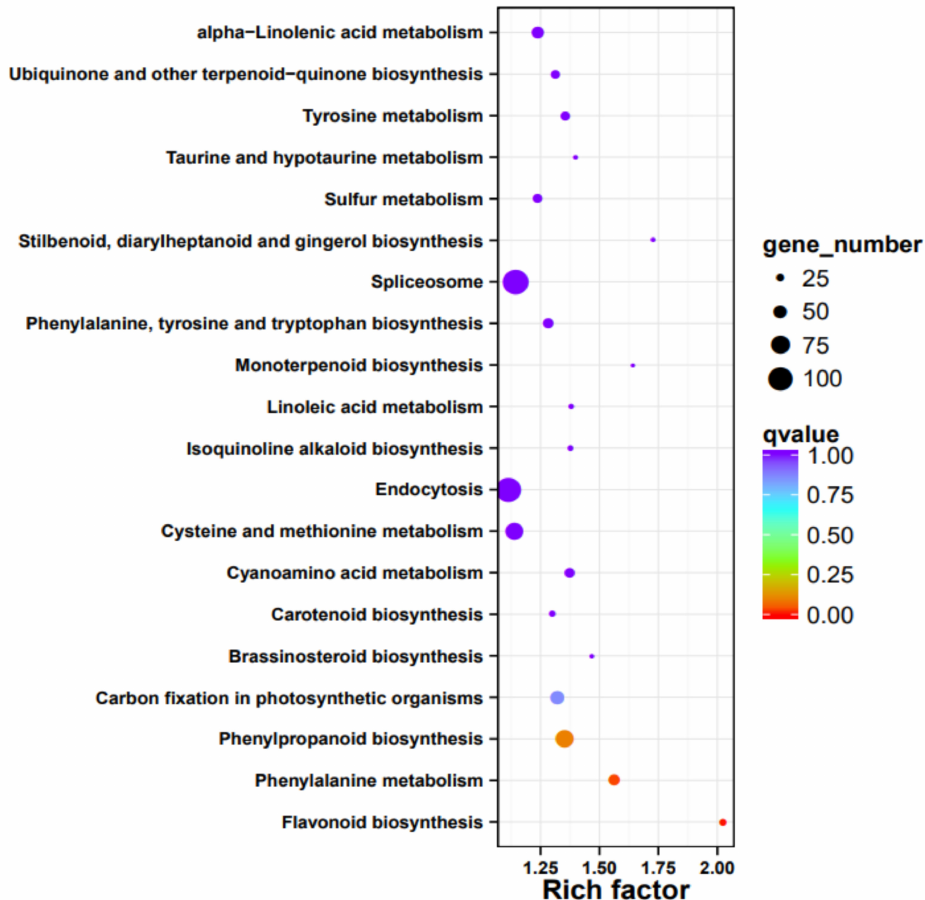
Figure 6. Pathway enrichment analysis based on the comparison of expression profiles from peels of purple vs. yellow fruits. Shown are the number of different sized dots (DEGs) of the top 20 regulated pathways. The rich factor on the x axes indicates the number of DEGs per pathway compared to the total number of genes in this